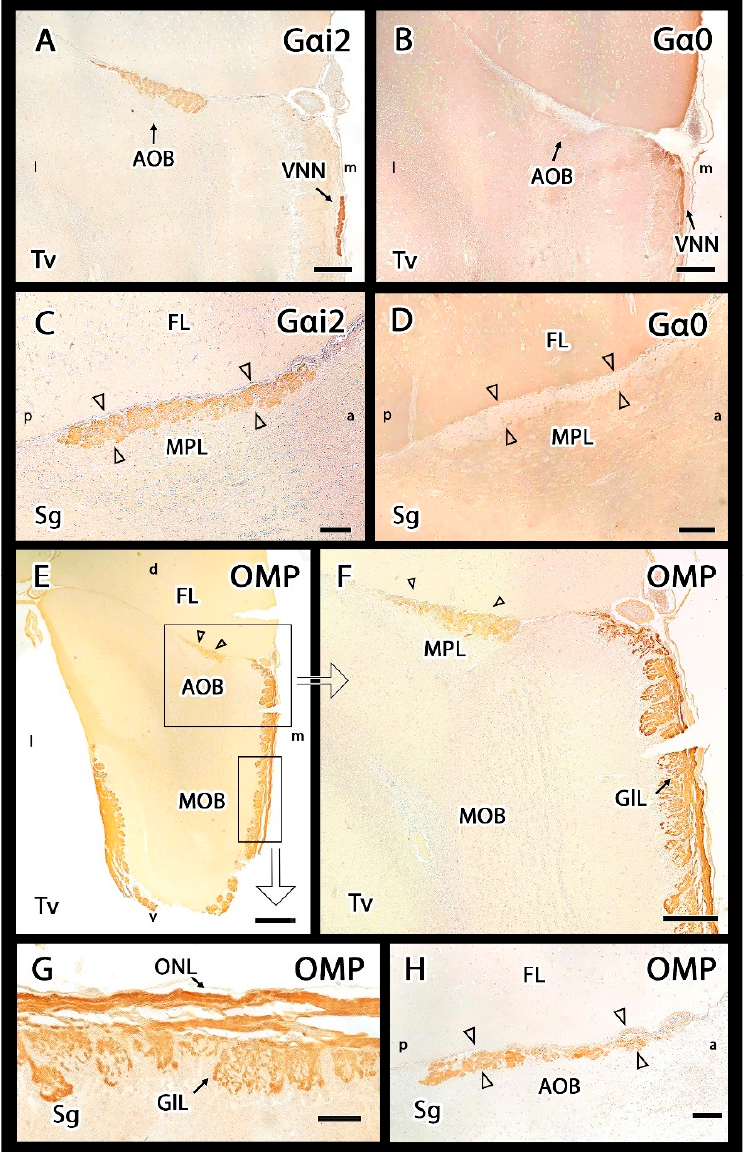
Figure 7. Immunohistochemical study of G α o, G α i2 and OMP proteins in the main and accessory olfactory bulbs of the meerkat. ( A , C ) Anti-G α i2 immunolabels specifically the accessory olfactory bulb (AOB). Transverse section ( A ) and hematoxylin counterstained sagittal section ( C ) show strong immunopositivity confined to the vomeronasal nerve and glomerular layers of the AOB